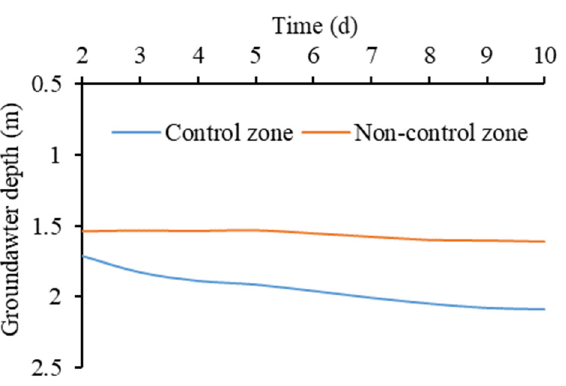
Figure 14. Changes in the topsoil ECe changing rates in control and non-control zones.